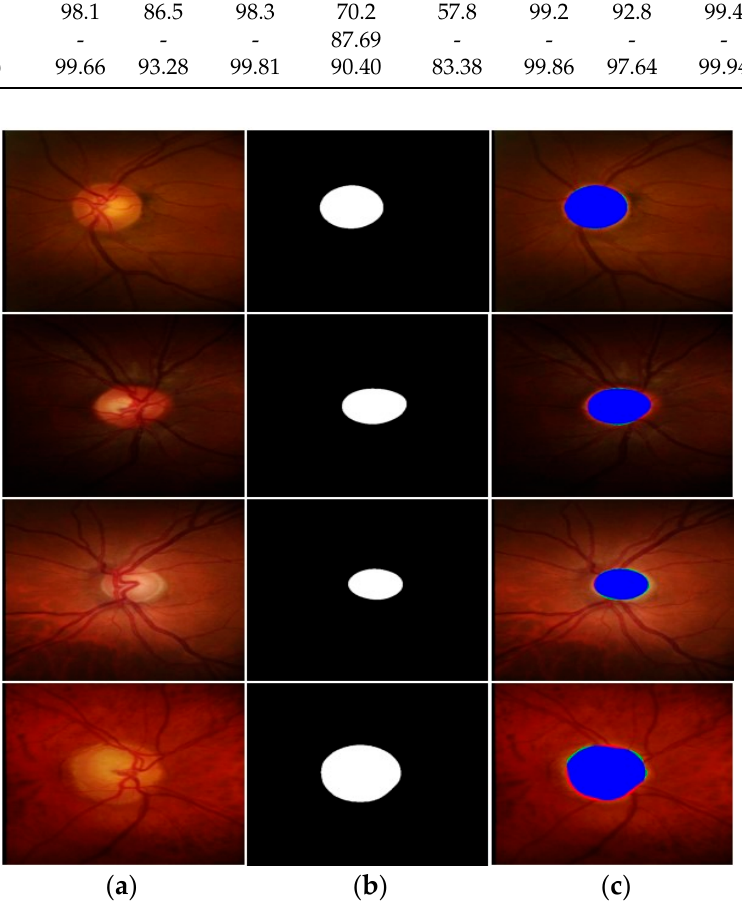
Figure 10. Good OD segmentation qualitative results on the Rim-One-r3 database, attained by applying FEDS-Net. ( a ) Input image, ( b ) corresponding groundtruth image, and ( c ) segmented output images (tp and fn pixels for OD are indicated in blue and red, respectively. Whereas fp pixels are presented with green color) (Rows 1–3: good segmentation results; Row 4: poor segmentation result).